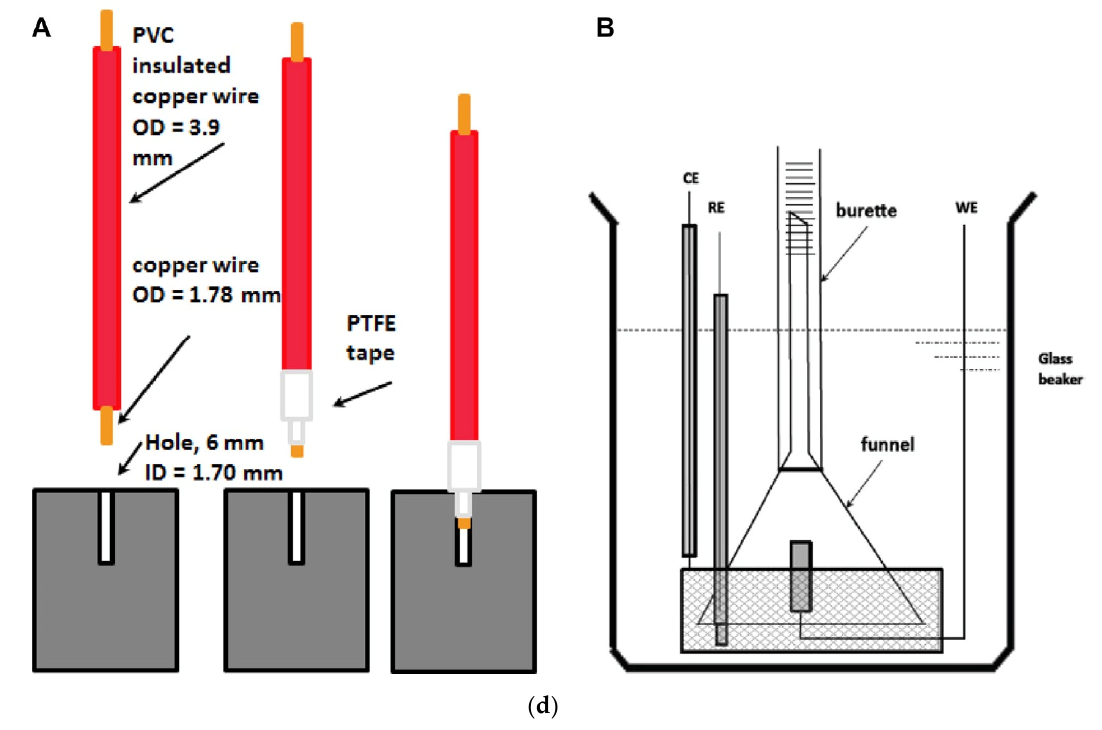
Figure 1. ( a ) Schematic for the apparatus for the measurement of the evolved hydrogen from a freely corroding Mg specimen [79]. The evolved hydrogen is channeled by an inverted filter funnel into a burette, which allows the periodic recording of the hydrogen volume. This technique has been modified to allow measurement using the buoyancy of the displaced water [80], nevertheless the principle remains the same. ( b ) An illustration of the fishing line method [76,77], wherein the Mg specimen is supported in the solution by a fishing line, so that the specimen surface exposed to the solution is maximized. ( c ) A Mg specimen mounted in metallurgical epoxy, with an electrical connec- tion to the back of the specimen to allow the specimen to be used for electrochemical measurements, such as illustrated in ( d ). The front surface can be ground and polished using standard metallurgical methods. ( d ) A plug-in specimen ((A) shows assembly of a plug-in specimen) and the arrangement (as shown in (B)) by which the plug-in specimen can be used for (i) weight loss measurements, (ii) measurements of the evolved hydrogen volume, and (iii) electrochemical measurements. The bared copper conductor is pressed into the undersized hole drilled into the Mg specimen to provide a reliable electrical contact. With care the electrical conductor can be removed after exposure to the corrosive solution allowing weight loss